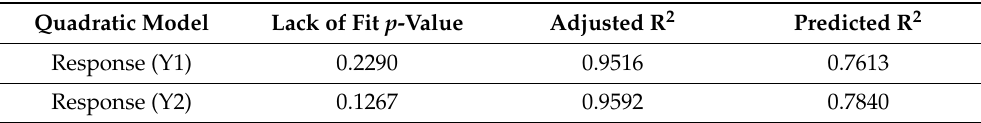
Table 3. Outline of results of regression analysis for responses Y1 and Y2 for fitting to the quadratic